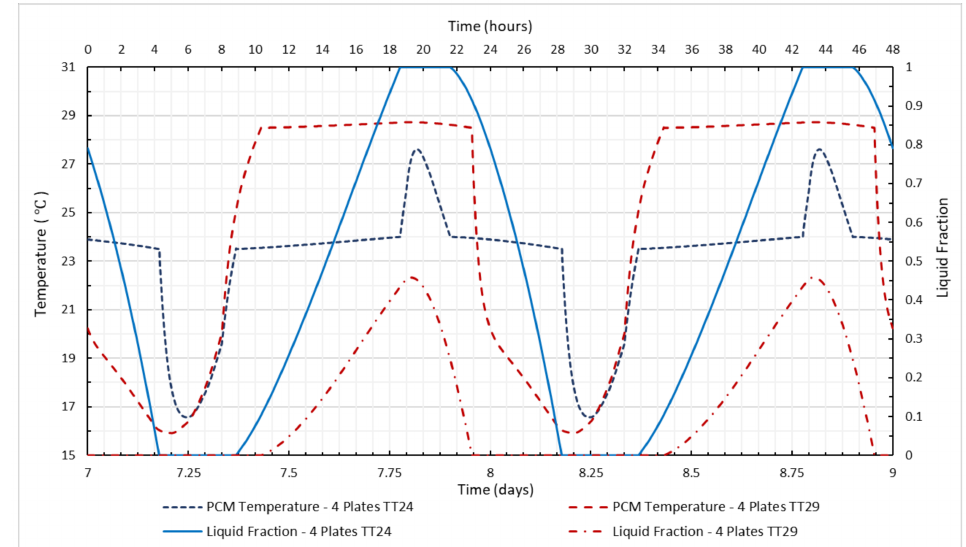
Figure 10. PCM temperature and liquid fraction for the room in low inertia configuration, during normal summer conditions, with forced convection.